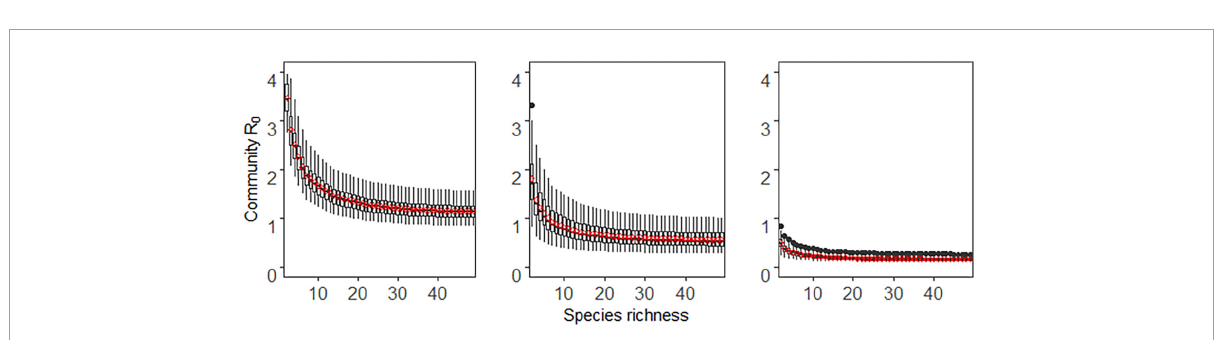
FIGURE4 The relationship between host species richness and community R 0 under frequency-dependent transmission and deterministic extinction scenario. Other details are the same as in Figure 3 .